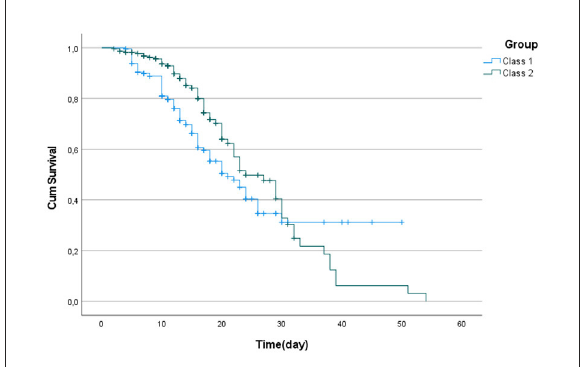
FIGURE2 Kaplan Meier curve for patients by classes.